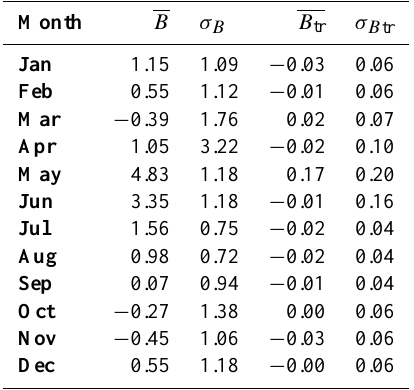
Table 2. Variability of annual averaged values of B (Wm − 2 ) over ATR using JRA reanalysis data for